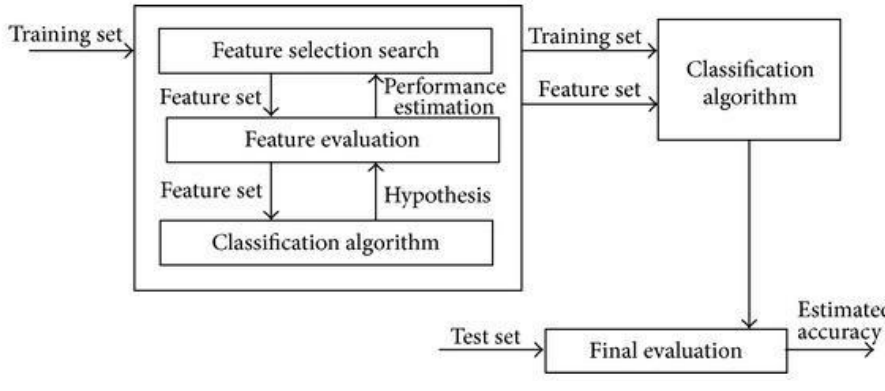
Figure 1. Flowchart of wrapper-based approach.